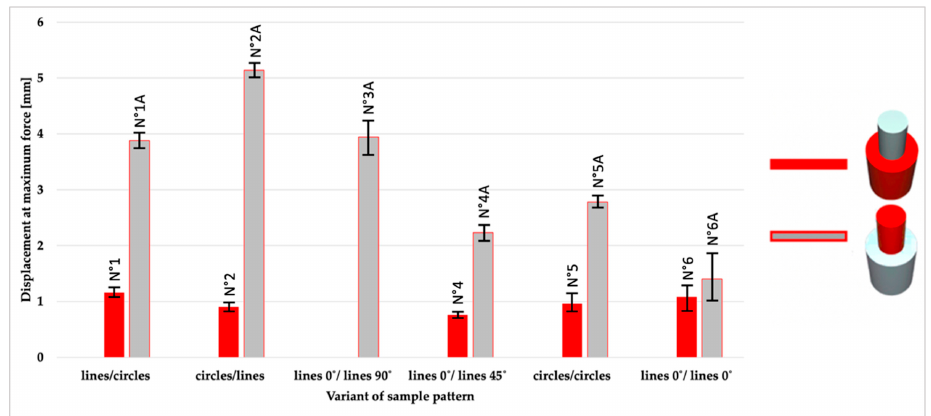
Figure 8. An overview of average shear strength for 11 series of samples (different configuration of patterns and material sequence).